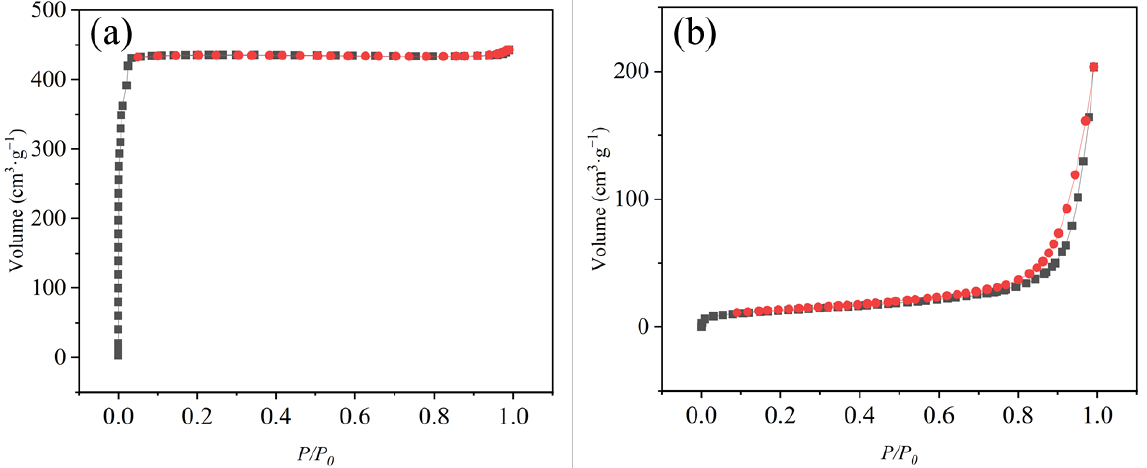
− desorption isotherms of ( a ) ZIF-8 ( b )